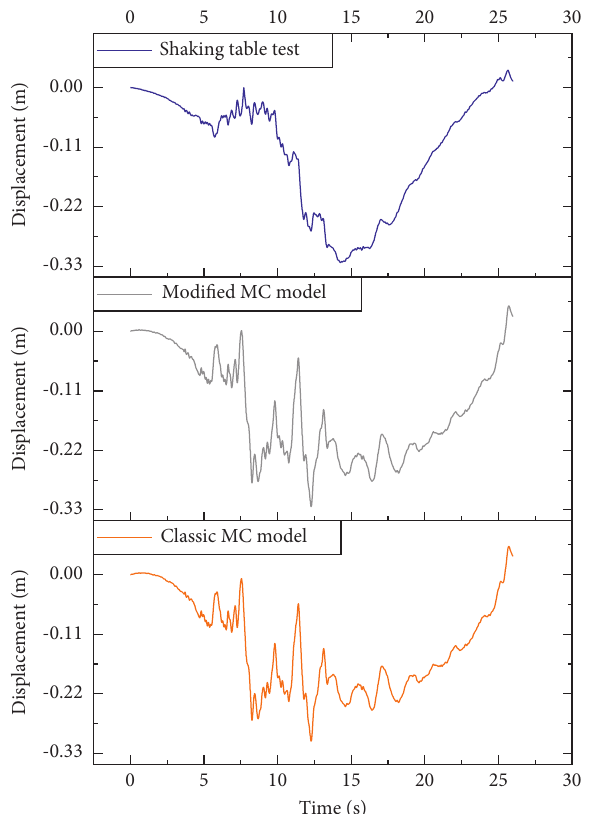
Figure 23: Displacement time history at point